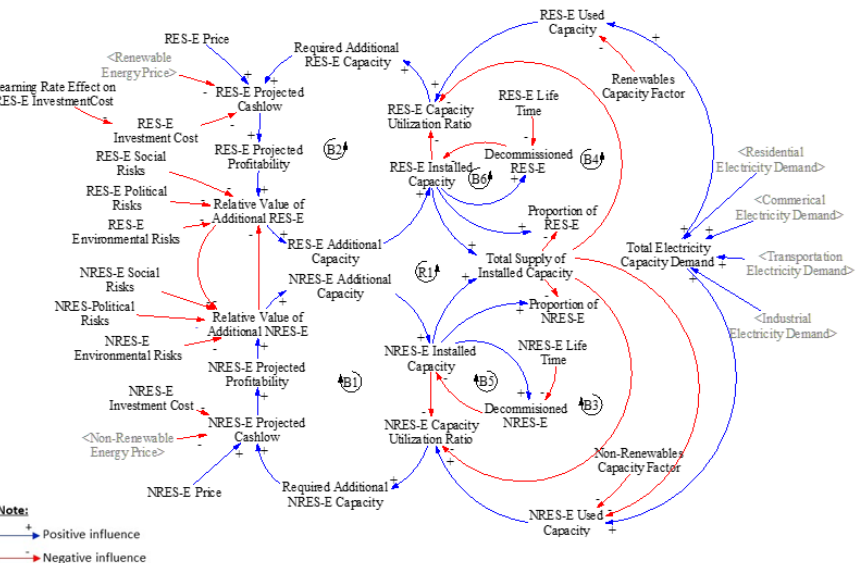
Figure 1. Choosing fossil-based power plants or RE-based power plants is an investment decision between two alternatives. Blue arrows are paired with (+) sign to indicate positive influence on the variable, red arrows paired with (-) indicate negative influence.